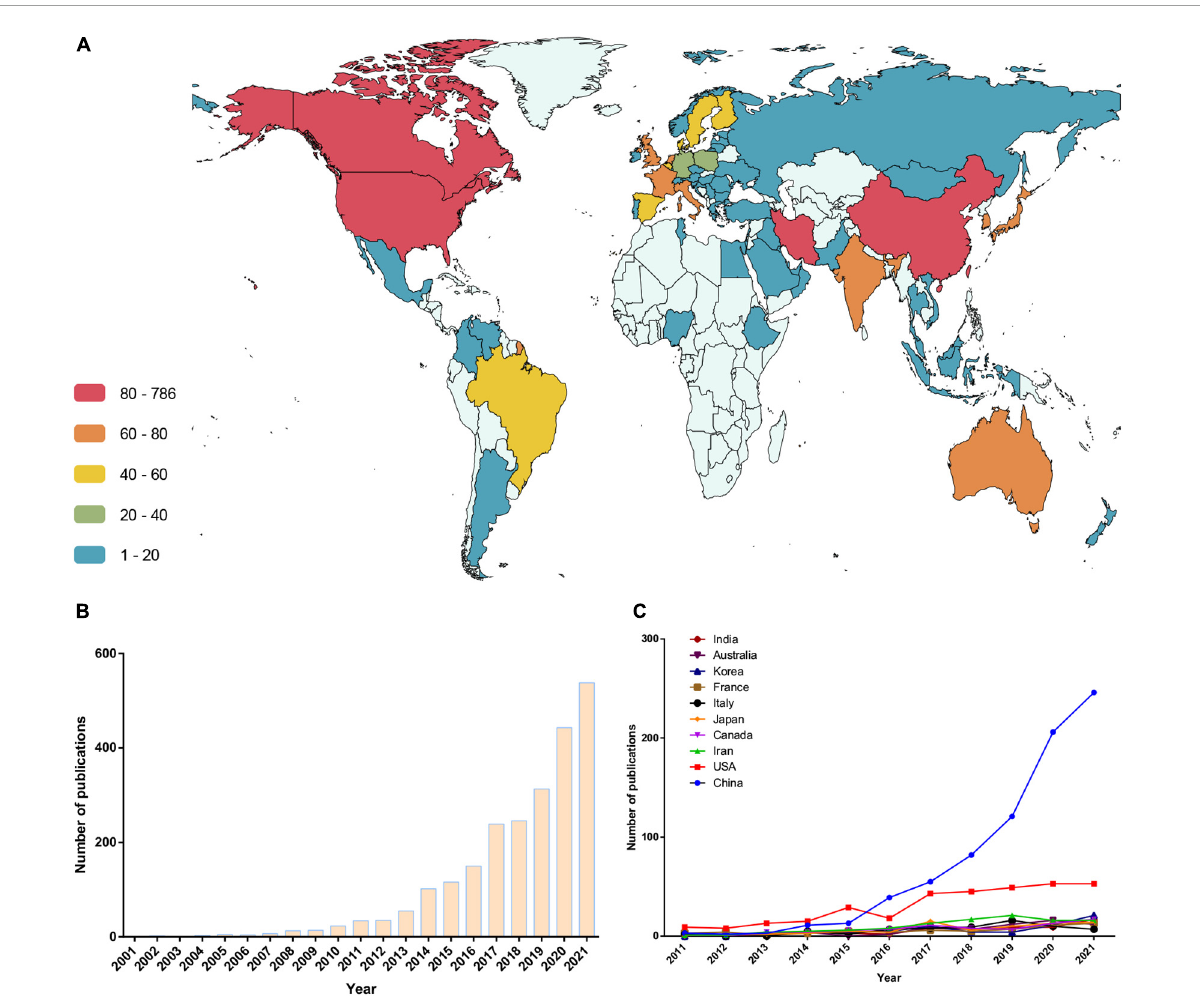
FIGURE2 Trends in the number of publications and analysis of country/regions in the “gut microbiota and diabetes” area. (A) Geographical distribution of publication. (B) The trend in the total number of publications in the past 21 years. (C) The trend in the number of publications in the top 10 productive countries.